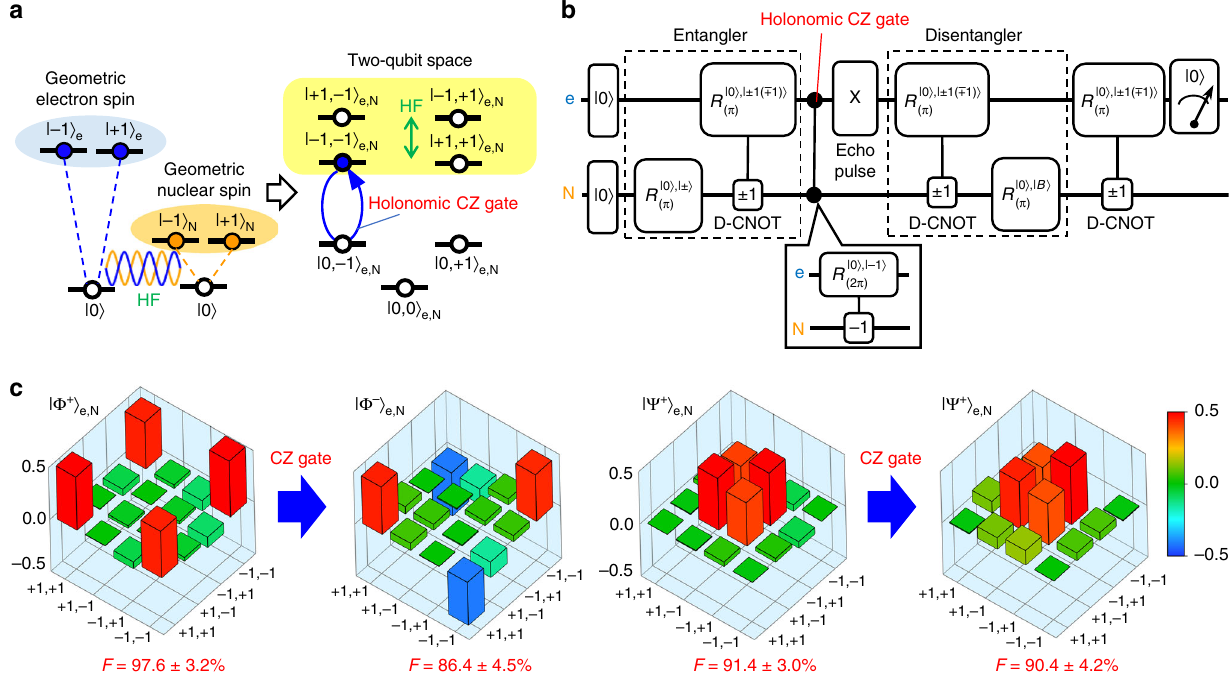
Fig. 3 Holonomic two-qubit gate. a Schematic energy level diagram showing the mechanism underlying the holonomic two-qubit gate for the hyper fi ne- coupled electron − nuclear spins. The holonomic controlled-Z (CZ) gate is performed by fl ipping the phase of the | − 1, − 1 〉 e,N state with a circularly polarised microwave resonant to one of hyper fi ne-split frequencies. b The quantum circuit to evaluate the holonomic two-qubit gate by using the dynamic CNOT (D- CNOT, Methods) gate together with the geometric spin echo 11 to compensate the phase evolution during the manipulation. c The real part of the density matrices of the two-qubit states reconstructed by the two-qubit quantum state tomography to show the transformation by the holonomic CZ gate. The bases denoted as ±1, ±1 indicate the |±1, ±1 〉 e,N states and the F indicates fi delity. The bars indicate the values of the matrix elements